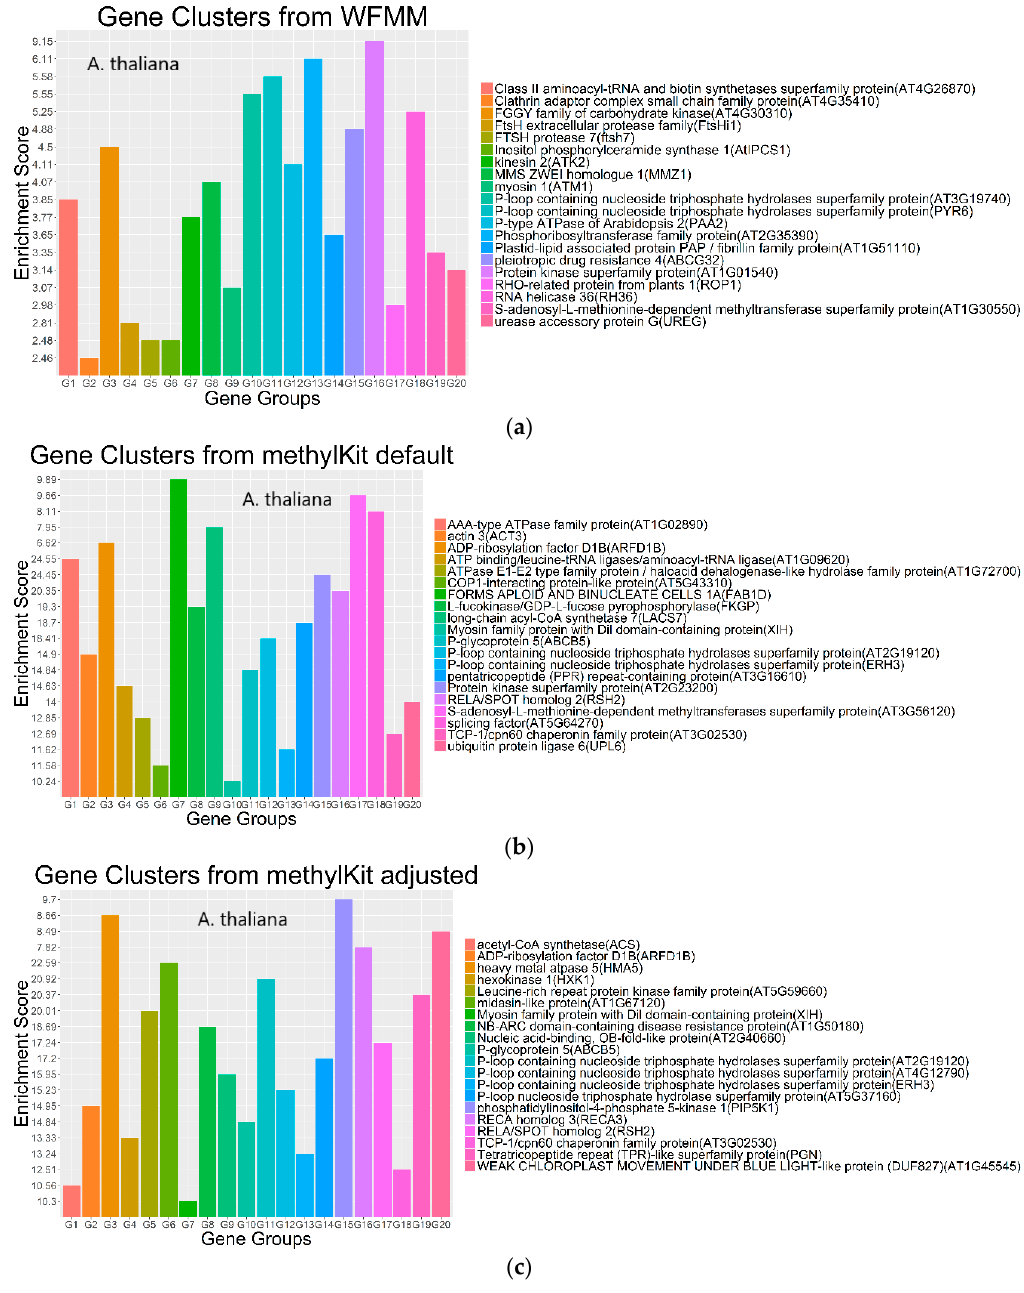
Figure 7. Gene clusters based on the gene ontology of molecular function for the top 3000 most significant genes from WFMM with δ = 0.01 ( a ), methylKit with default settings (difference = 25; q value = 0.01) ( b ), and methylKit with adjusted settings (difference = 4; q value= 1.00) ( c ).